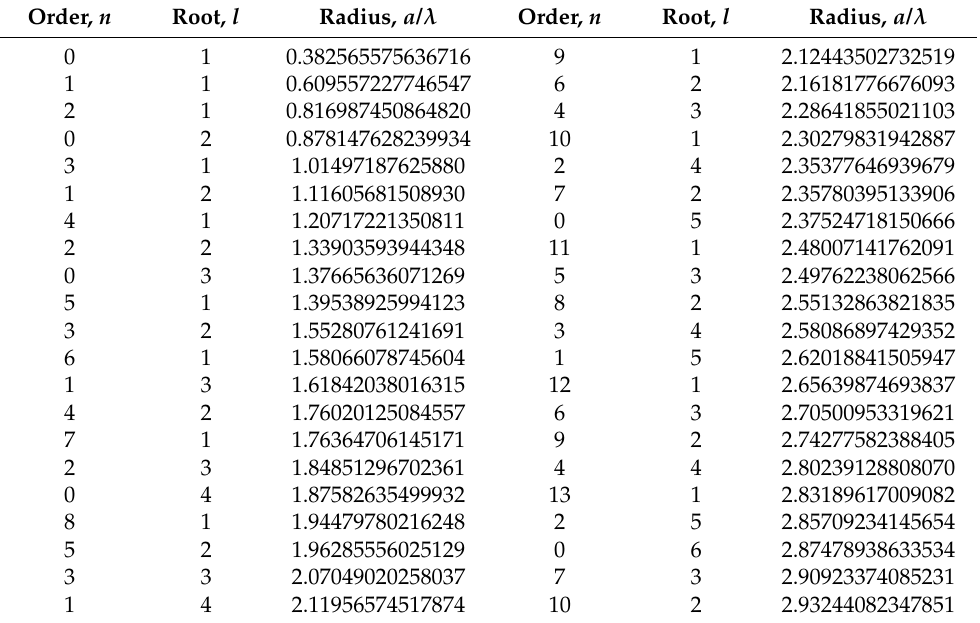
Table 1. First TM nl resonances versus the radius of the conducting enclosure (for radiuses up to 3 λ ). Order, n Root, l Radius, a / λ Order, n Root, l Radius, a / λ 0